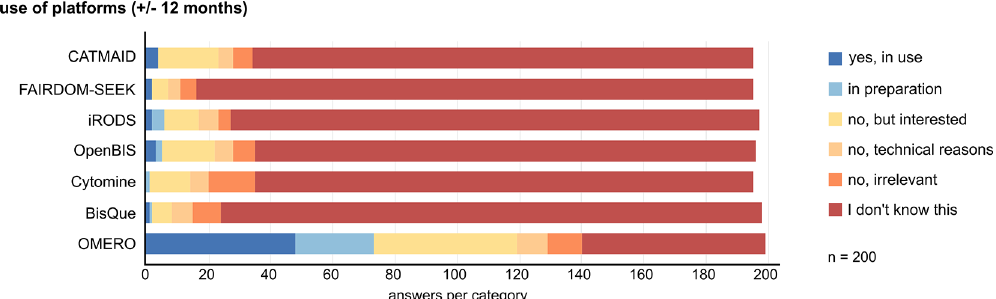
Figure 4. Data management platform knowledge and use by participants. We presented a list of generic and image-data-tailored management systems and asked respondents for their use, interest, and knowledge about each system on the indicated scale. Abbreviations: CATMAID Collaborative Annotation Toolkit for Massive Amounts of Image Data; FAIRDOM-SEEK Findable, Accessible, Interoperable and Reusable Data, Operating procedures and Models; iRODS Integrated Rule-Oriented Data System; OMERO Open Microscopy Environment Remote Objects; OpenBIS Open Biology Information